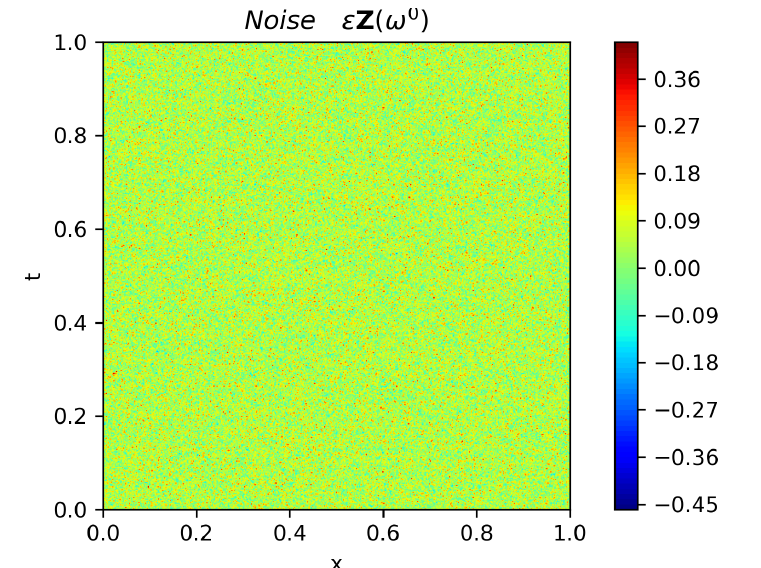
Figure 2. The realization of the noise term Z ( ω 0 ) in (18) that yields the full observation in the right panel of Figure 1. The noise magnitude is set to (cid:101) ∗ =